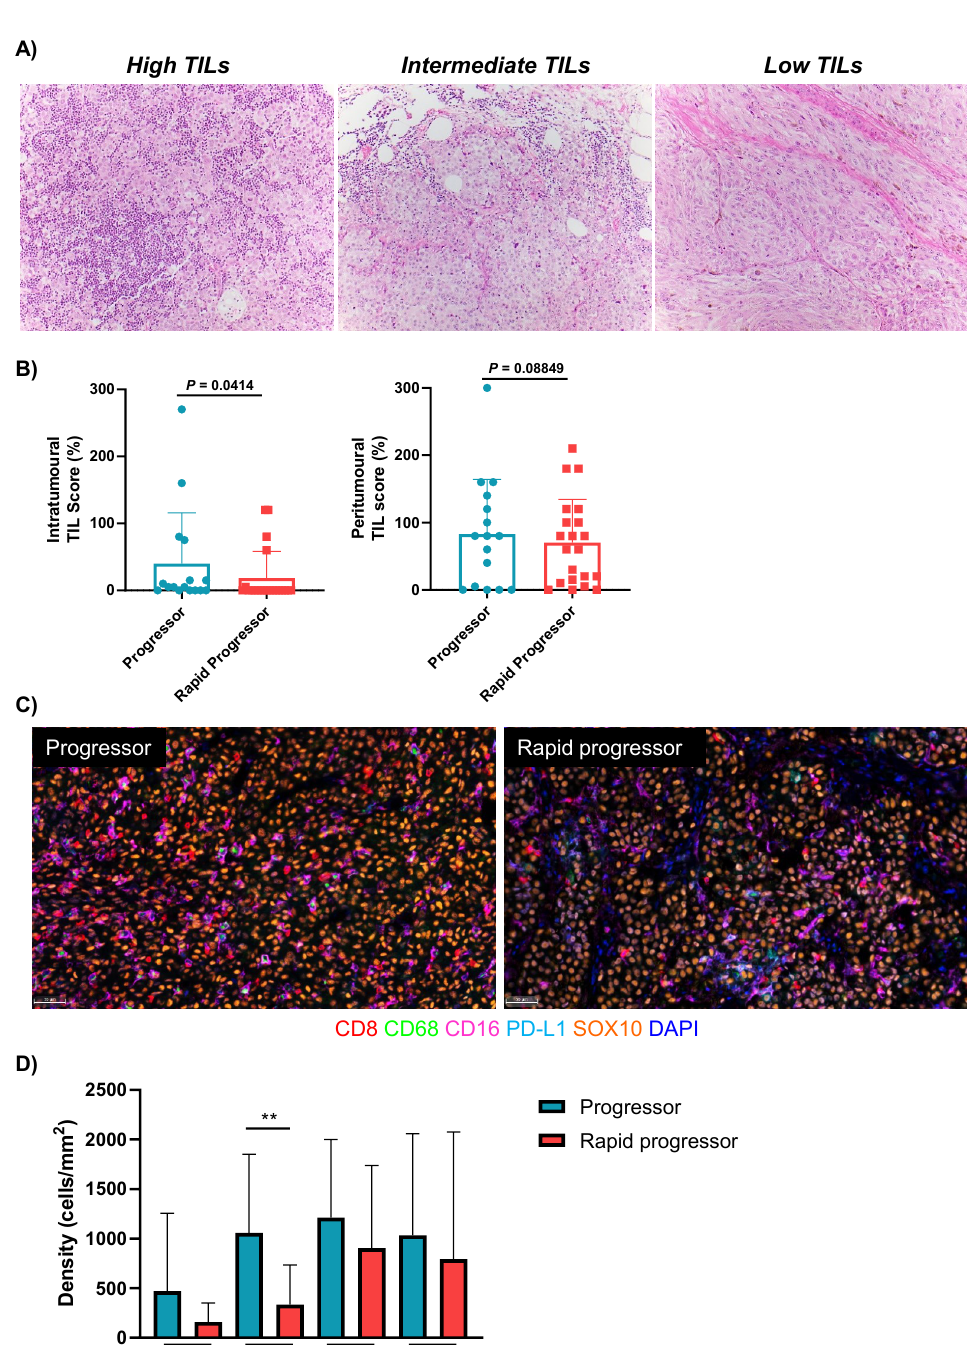
Figure 2. Immune profiles of non-responders to anti-PD-1-based therapies. ( A ) Non-responding melanomas showing variation in the degree of tumour-infiltrating lymphocytes (TILs). Representative photomicrographs demonstrate the three grades of TILs: high TILs—diffuse infiltrates of moderate to marked intensity; intermediate TILs—marked focal, moderate multifocal, or mild diffuse infiltrates; and low TILs—absent or focal mild infiltrates. ( B ) Box plots comparing the intratumoural and peritumoural TIL score between rapid progressors ( n = 21) and progressors ( n = 16). ( C ) Representative multiplex immunofluorescent images of intratumoural regions stained with CD8, CD68, CD16, PD-L1, SOX10 and DAPI, from a progressor and rapid progressor on anti-PD-1-based therapy. ( D ) Bar graphs comparing the densities of intratumoural immune cell populations between progressors ( n = 12) and rapid progressors ( n = 16). Error bars represent mean ± SD. ** p <